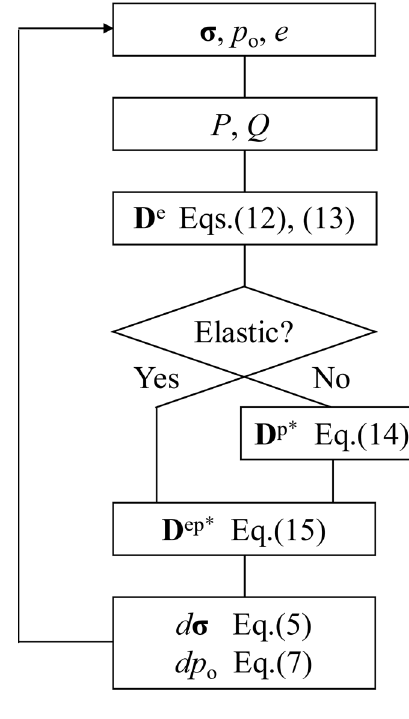
Table 1. Equivalent sum costs of the main stages that conform to a conventional explicit integration algorithm and an algorithm with the proposed procedure.